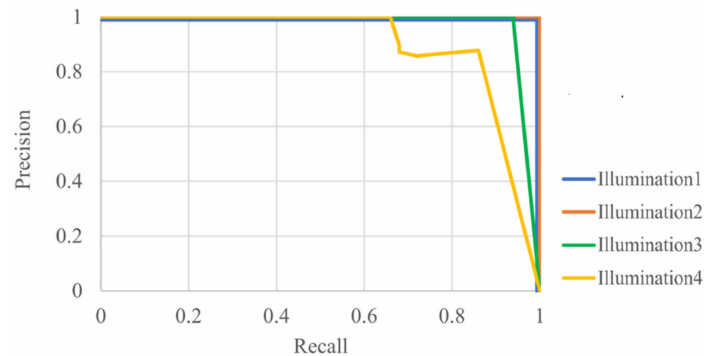
Figure 24. The P-R curve of AlexNet under different illuminations.